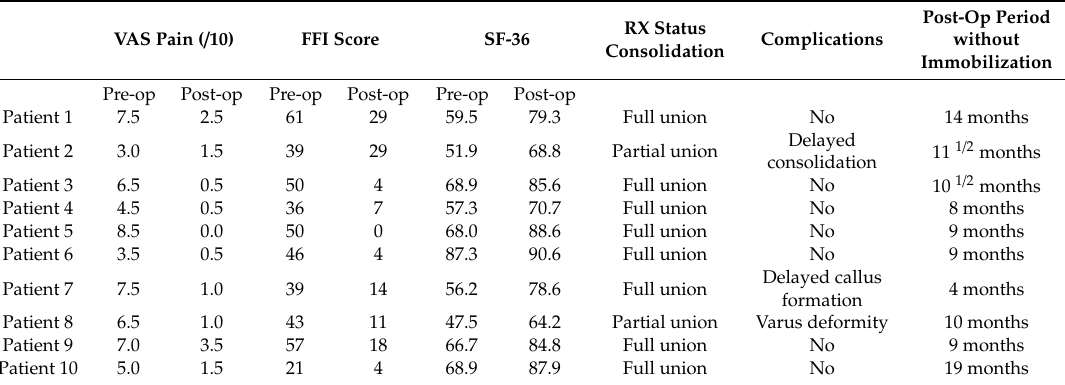
Table 2. Questionnaire and post-operative radiographic and clinical